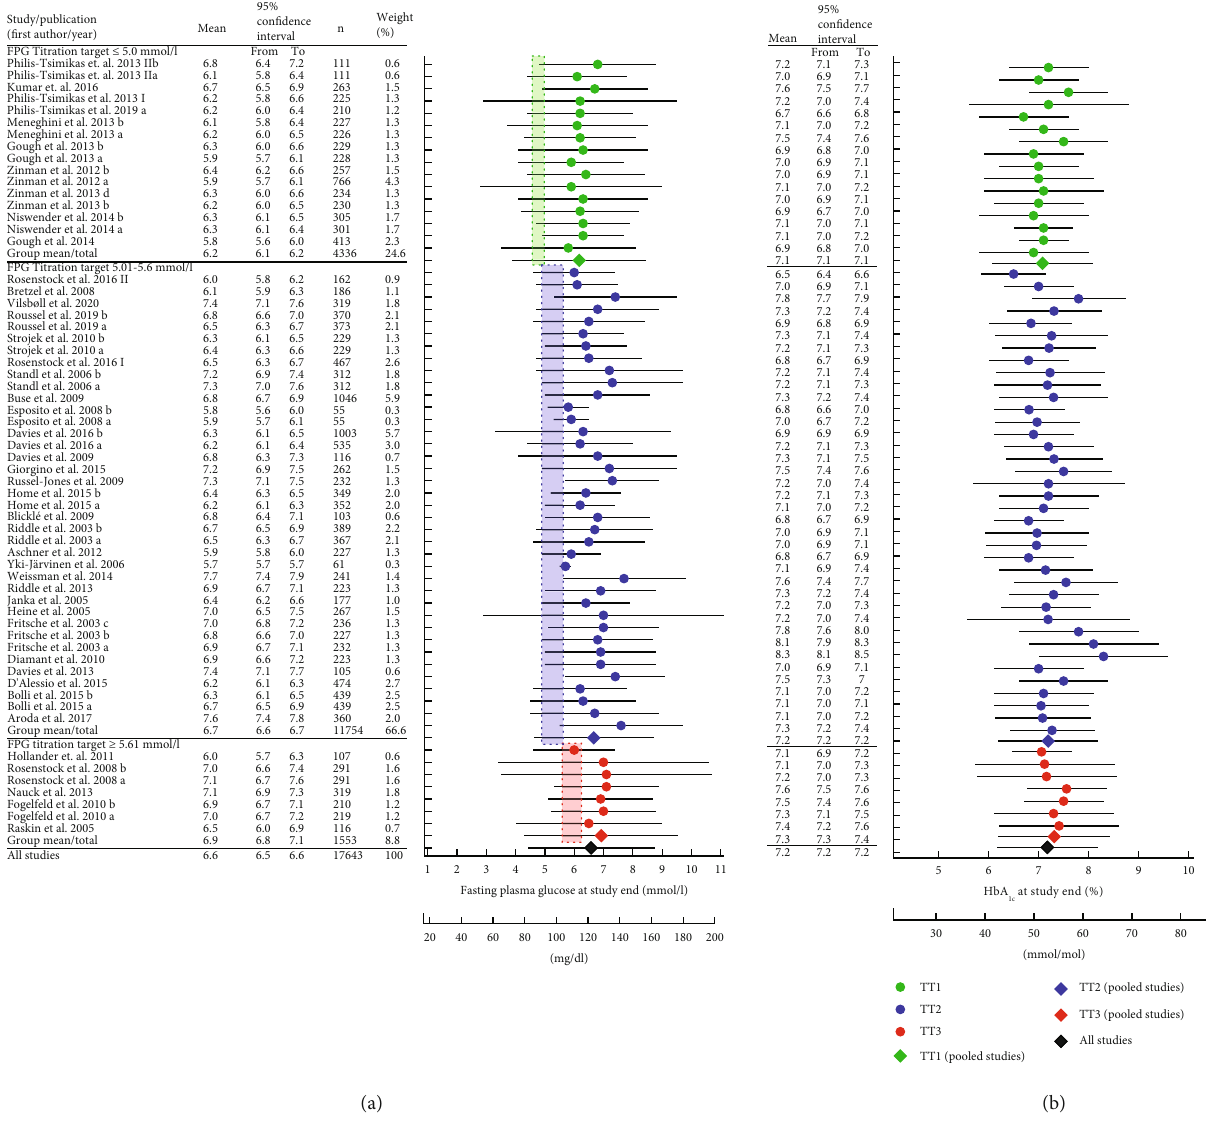
Figure 1: Forrest plot of fasting plasma glucose (a) and HbA (b) concentrations achieved after basal insulin titration according to 1c categories of fasting plasma glucose titration target (TT): 1 ( ≤ 5.0, green symbols), 2 (5.01-5.60 mmol/l, blue symbols), and 3 ( ≥ 5.60mmol/l; red symbols). Individual studies are shown with fi lled circles, and pooled results re fl ecting the three categories of fasting plasma glucose targets are shown as diamonds. Means ± standard deviation . The range of fasting plasma glucose titration targets for the three categories is shown as a colored shaded